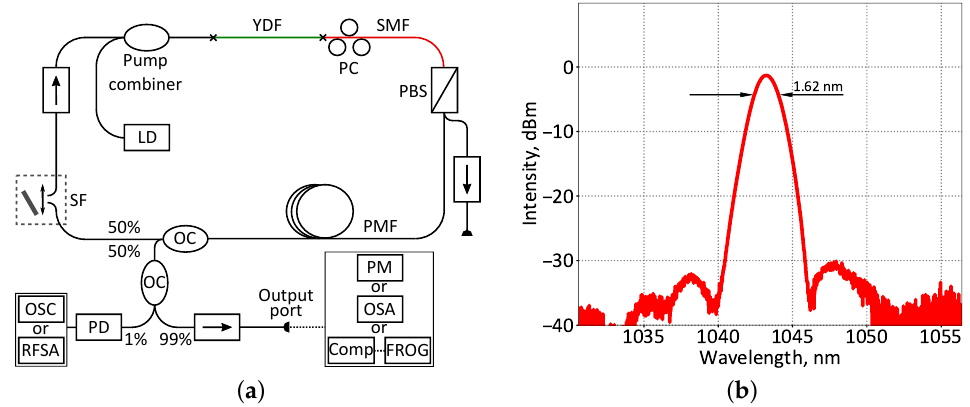
Figure 1. Scheme of the experimental setup ( a ): LD—laser diode, YDF—double-clad Yb-doped fiber, PC—polarization controller, SMF—single-mode fiber, PBS—polarizing beam splitter, PMF— polarization-maintaining fiber, OC—optical coupler, SF—spectral filter, PD—photodiode, OSC— oscilloscope, RFSA—radio frequency spectrum analyzer, PM—power meter, OSA—optical